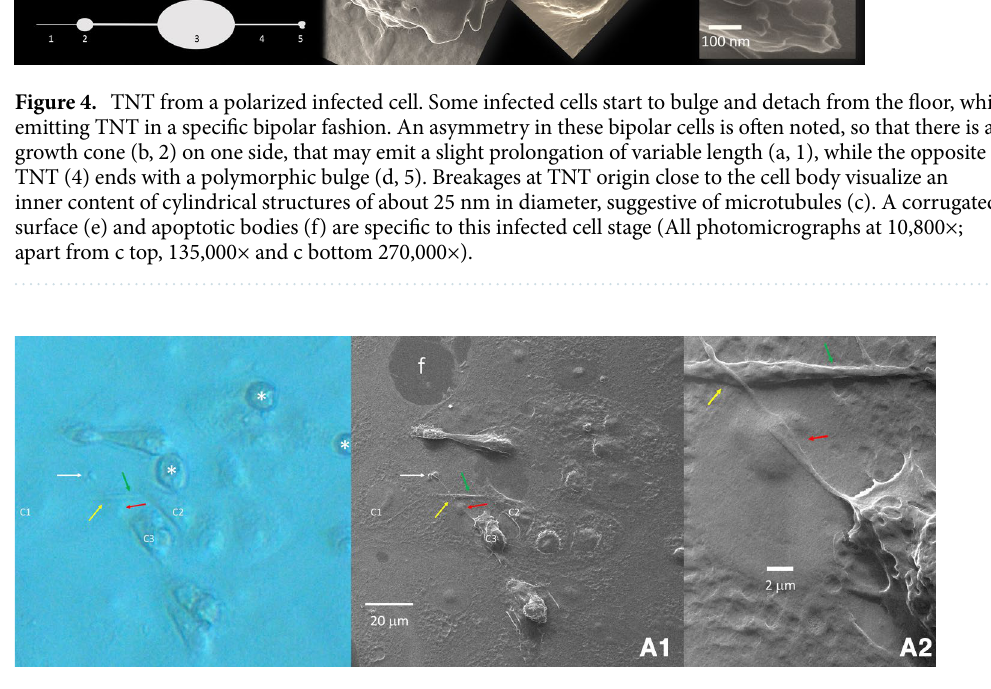
Figure 5. TNT overlap. An area of 130-micron square has been imaged ( A1 ) that shows a TNT originating from cell C3 overlapping another TNT which connects cells C1 and C2 (green arrow). A region shows the bare floor of the culture well (f). TNT keep their individual structure when they cross each other (yellow arrow), but they may fuse their membrane when they overlap a cell (red arrow) (magnification in ( A2 )). The specific morphology often seen in a TNT polymorphic bulged termination is pointed by a white arrow. Correlation with a phase contract image taken before HeIM (left) shows three rounded infected cells detached from the floor (asterisks) that were no longer present in the subsequent HeIM